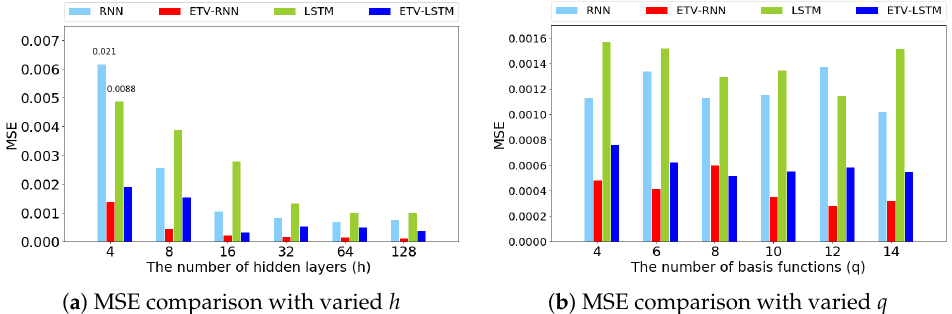
Figure 8. The influence of the number of hidden units and the number of basis functions on the many-to-many stock prediction results.